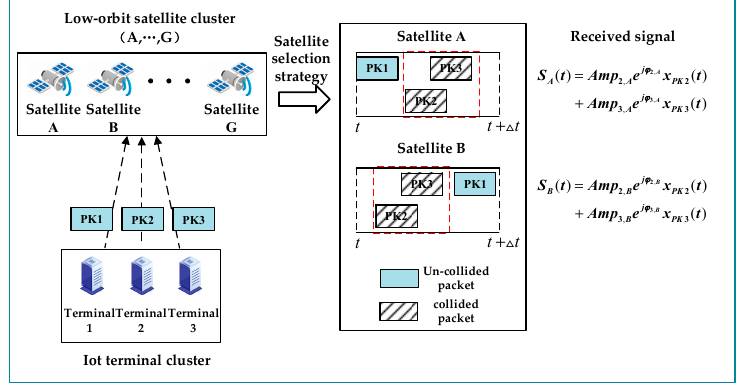
Figure 2. Multi-satellite selection algorithm application diagram.